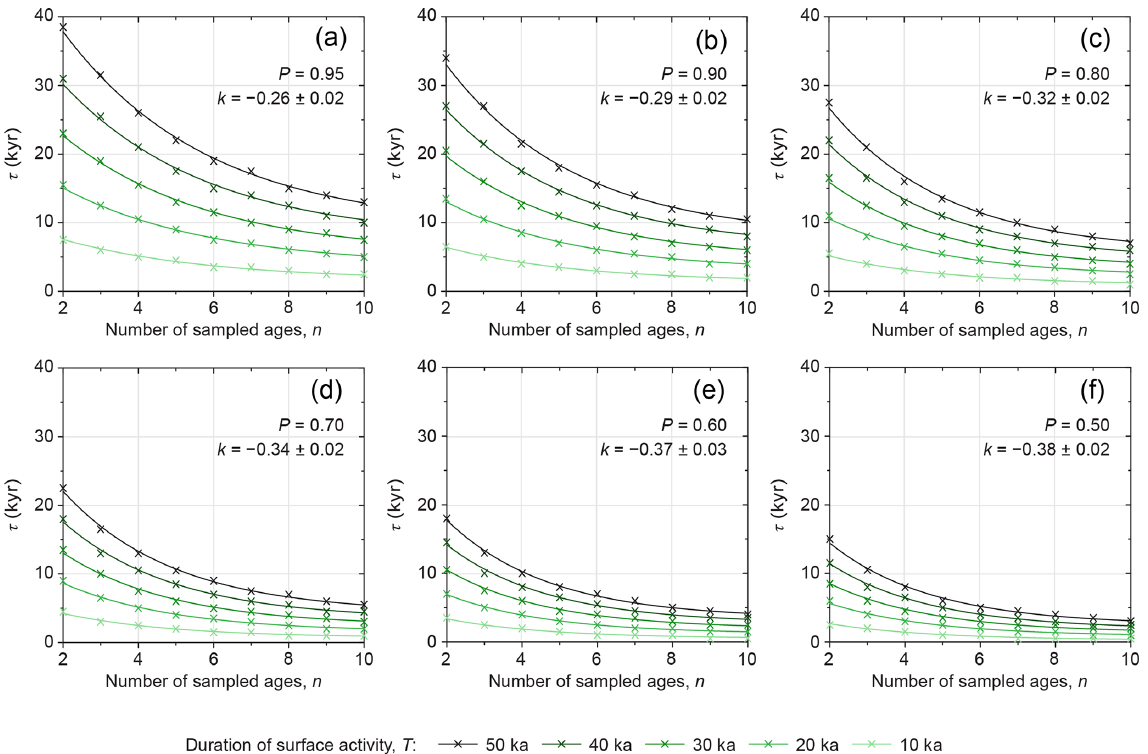
Figure 4. The probable abandonment window, τ , as a function of the number of boulder ages, n . Data are shown for different probabilities, P (panels), and durations of surface activity, T (colours). Parameter k is a decay constant that depends on P (see text for